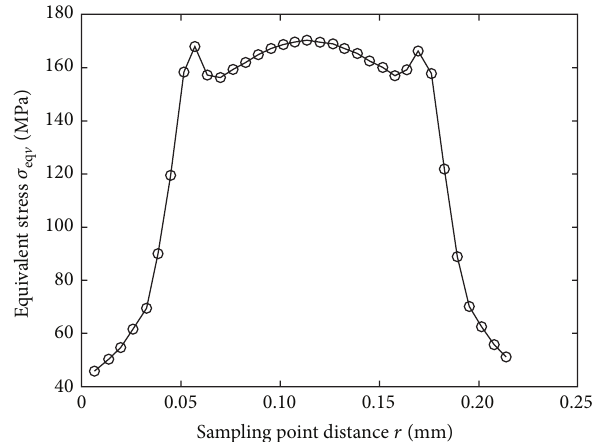
Figure3:Theequivalentstressdistributionofselectedpointsontwo sides of the surface of V-shaped notch.